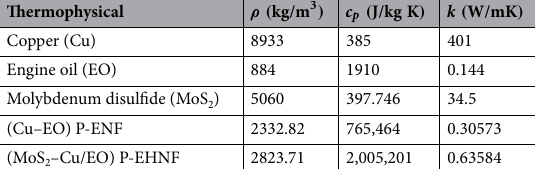
Table 3. Fabricated materials thermo-physical attributes.